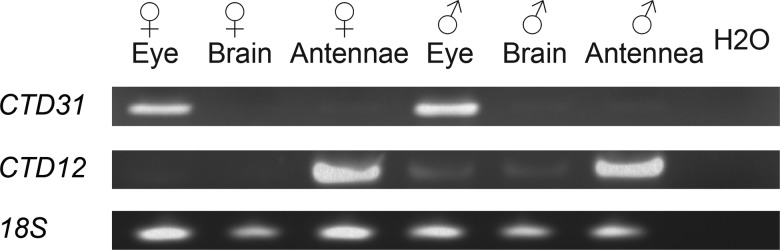

—Hme CTD31 RT-PCR. RT-PCR of Hme CTD31, Hme CTD12, and 18 S in female and male eye, brain, and antennae.